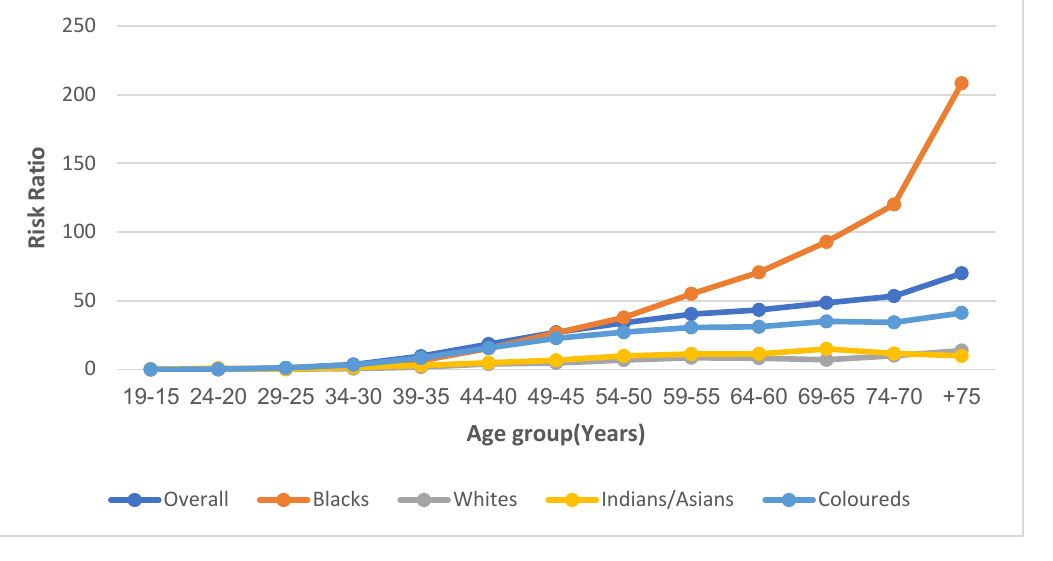
Figure 5. Age effect (Risk ratio) of the National and ethnic cervical cancer mortality in South Africa (1999 – 2018).